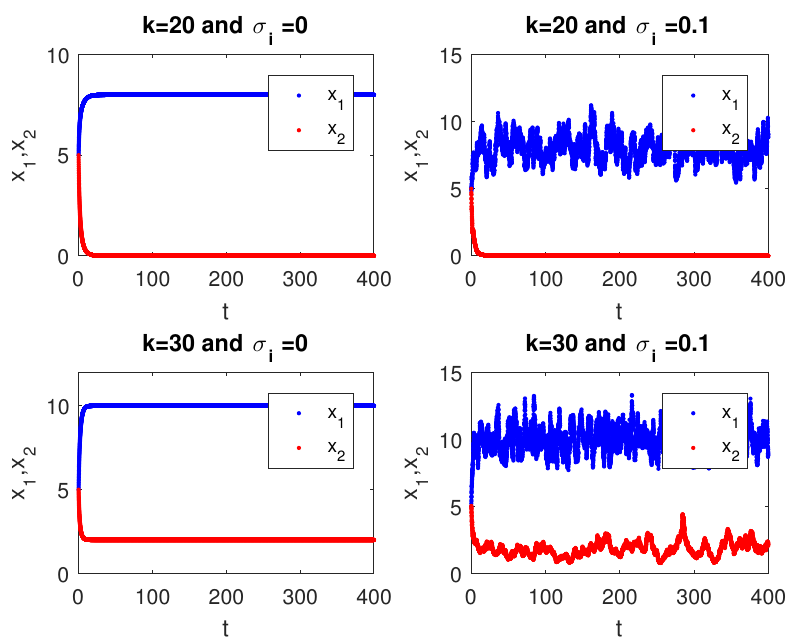
Figure 4. The stochastic behavior of the Abramson system for k = 20,30, and σ i =